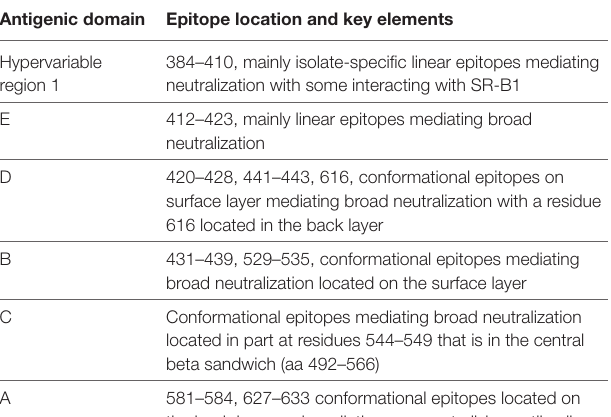
Table 1 | Immunogenic clusters as defined by antigenic